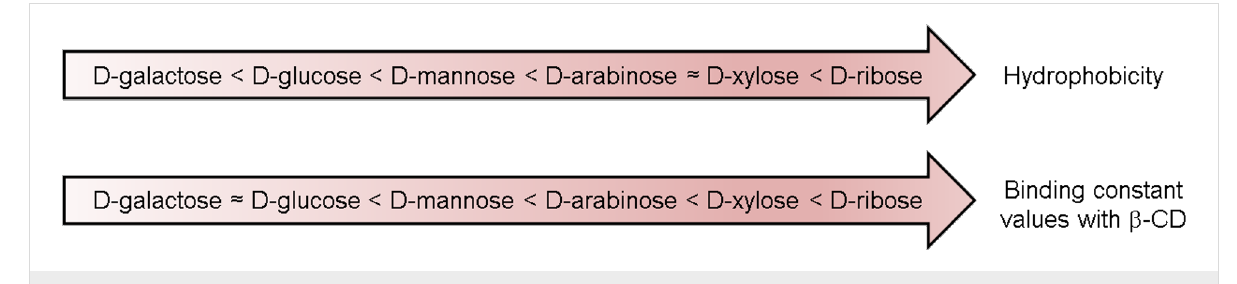
Scheme 4: Sugar hydrophobicity scale according to Janado and Yano and correlation with the binding constant values observed with β -CD.